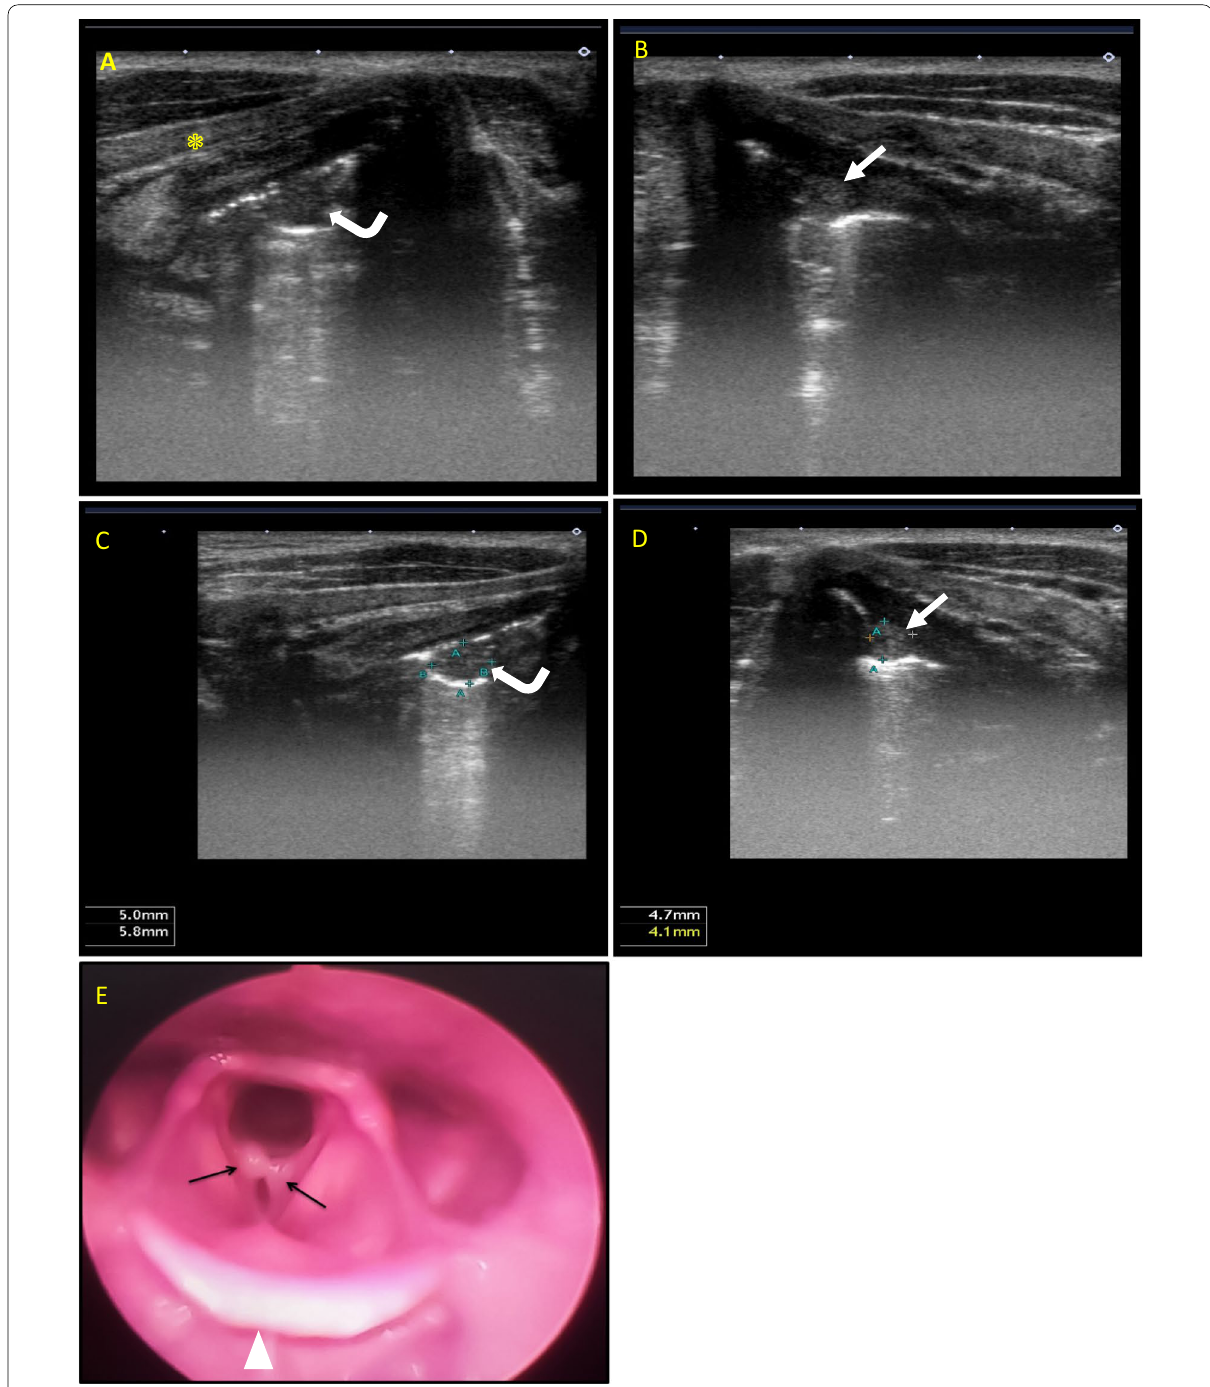
Fig. 1 A 30-year-old heavy smoker, male patient presented with hoarseness of voice. A & C Laryngeal ultrasound right lateral axial views show a right VC hypoechoic small nodule ( curved arrows ) measuring about 5 5.8 mm with posterior acoustic enhancement (thyroid cartilage landmark × with asterisk). B & D Laryngeal ultrasound left lateral axial views show left VC hypoechoic small lesion ( white arrows ) measures about 4.7 4.1 × mm with posterior acoustic enhancement. The vocal cord nodules show internal echoes, and this raises the possibility of highly proteinaceous or hemorrhagic cysts. E Flexible laryngoscopy with the anterior is at the bottom of this figure (epiglottis marked by arrow-head), reporting bilateral vocal cord polyps ( black arrows ). Endoscopic removal of the vocal cord lesions and histopathology assessment revealed complicated cysts matching the sonographic findings as acoustic enhancement in ultrasound confirms that it is a cystic lesion rather than vocal